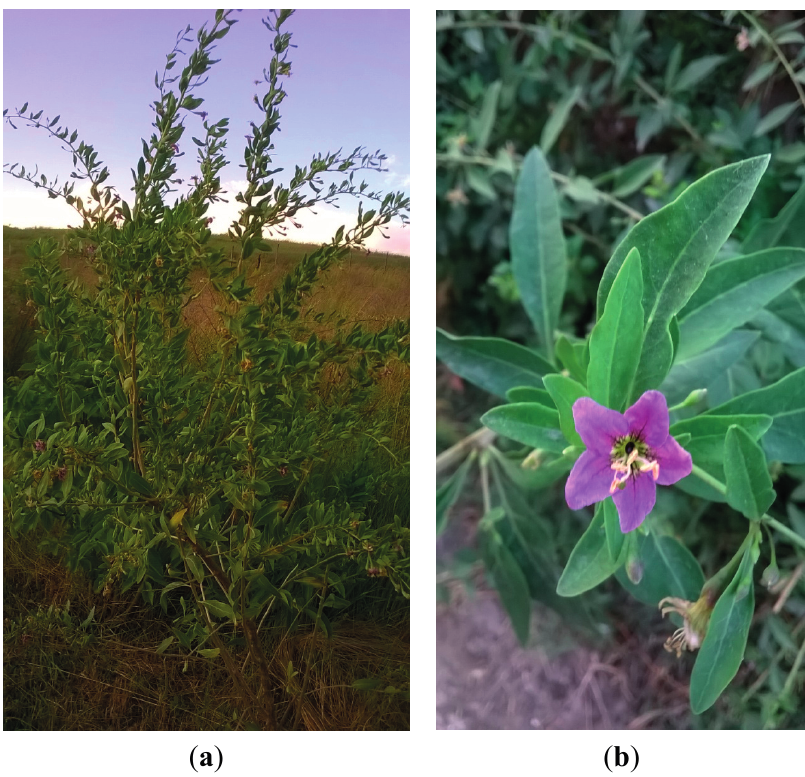
Figure 1. ( a ) General picture of L. barbarum ; ( b ) detailed picture of the L. barbarum flower.